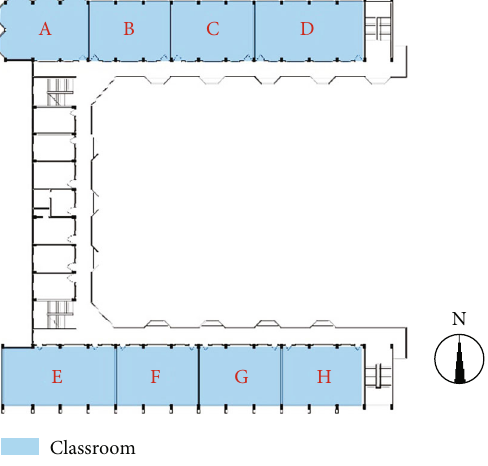
Figure 4: The building plan of the